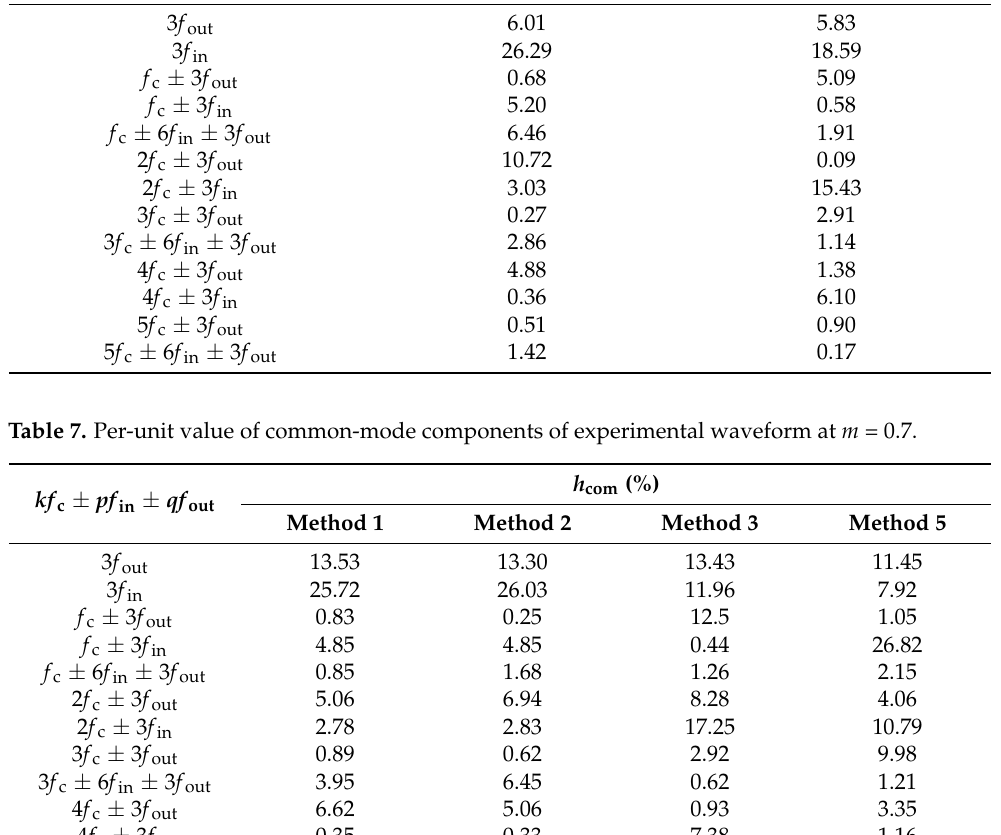
Table 6. Per-unit value of common-mode components of experimental waveform at m = 0.3. kf c ± pf in ± qf out